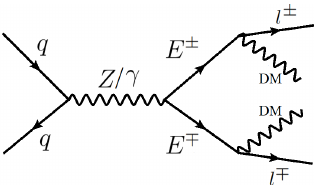
Figure 1 . Representative Feynman diagrams for vector-like lepton production and subsequent decays at the